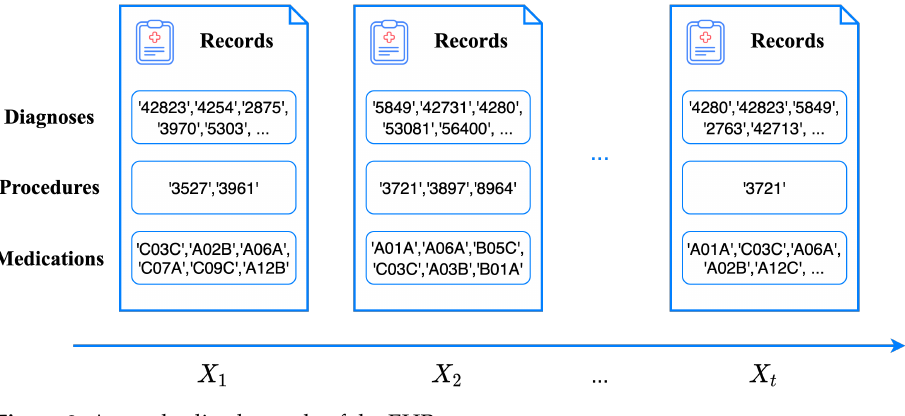
Figure 2. A standardized sample of the